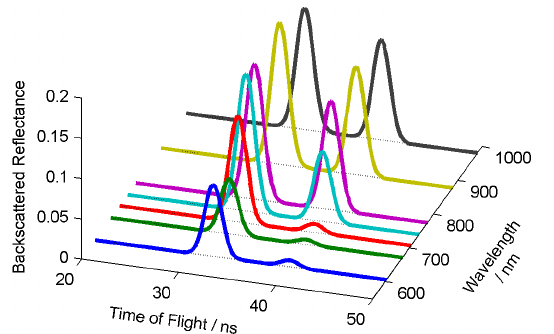
Fig. 2. Result waveforms for each channel after post processing. Gaussian peaks are fitted to each of the measured echoes. The first echo is produced by target spruce and the second by black cotton background